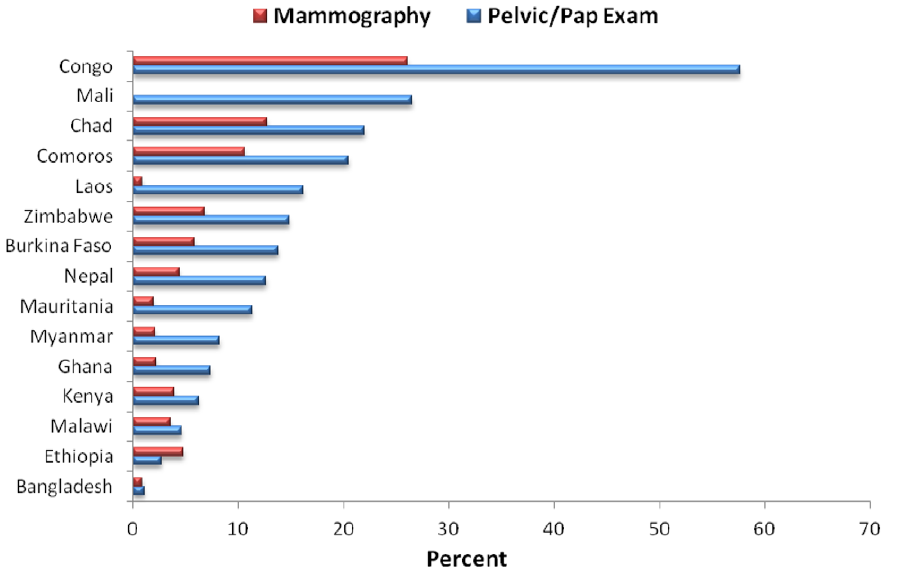
Figure 1. Pelvic Exam/Pap and Mammography Screening among Women Ages 18–69 (Pelvic/Pap) and 40–69 (Mammography) in Low-Income Countries, 2002–2003.